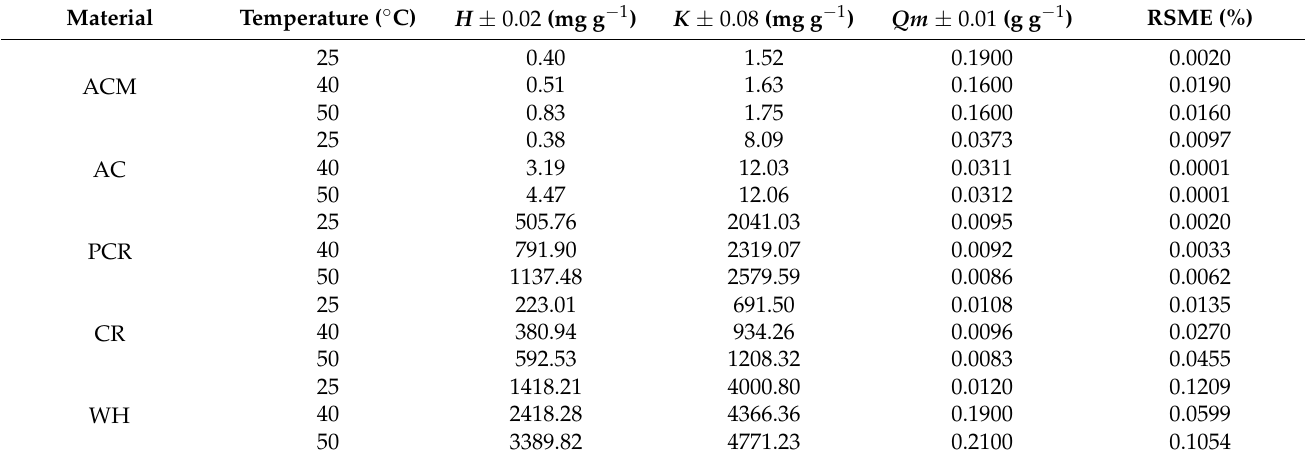
Table 4. SLE model parameters crude oil adsorption over at 25 ◦ C, 40 ◦ C, and 50 ◦ C for activated carbon modified with 5.0 wt.% of magnetite nanoparticles (ACM), the synthesized activated carbon (AC), the pyrolyzed coffee residue (PCR), coffee residue (CR), and walnut shell